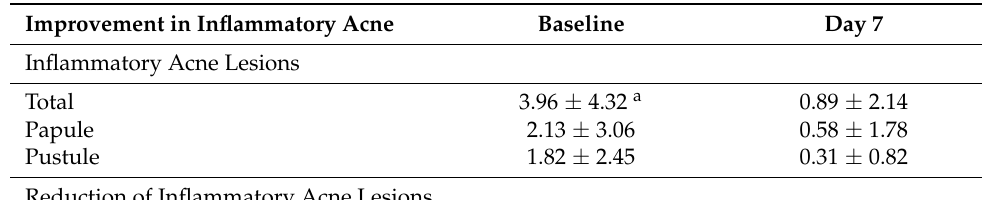
Table 6. Improvement in inflammatory acne lesions in 45